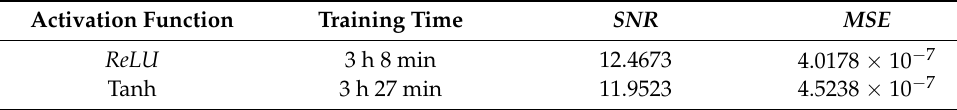
Table 1. The comparison experiment of activation function.